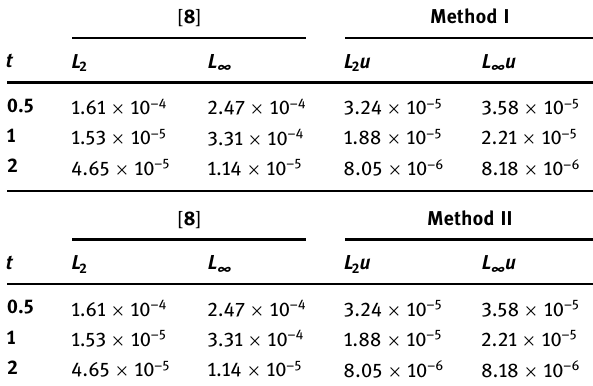
Table 17: Comparison of errors for = α 10 , = β 5 , = N 21 , = t Δ 0.0001 , and = τ 0.5 regarding Example 6